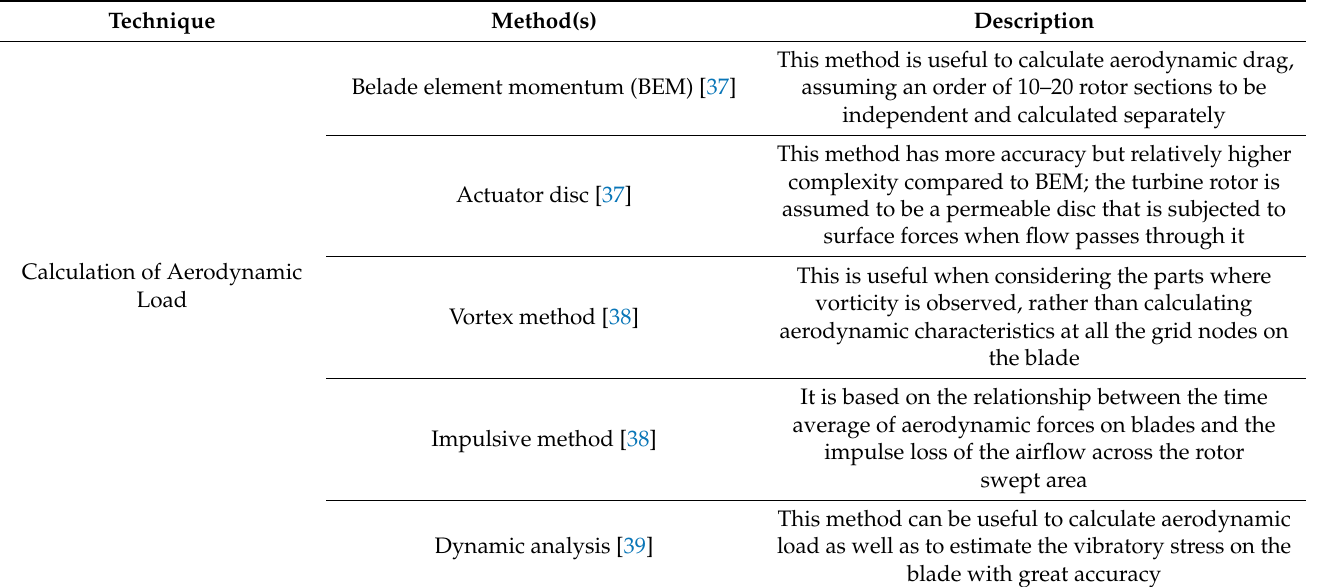
Table 2. Summary of techniques to design efficient vertical axis wind turbine.